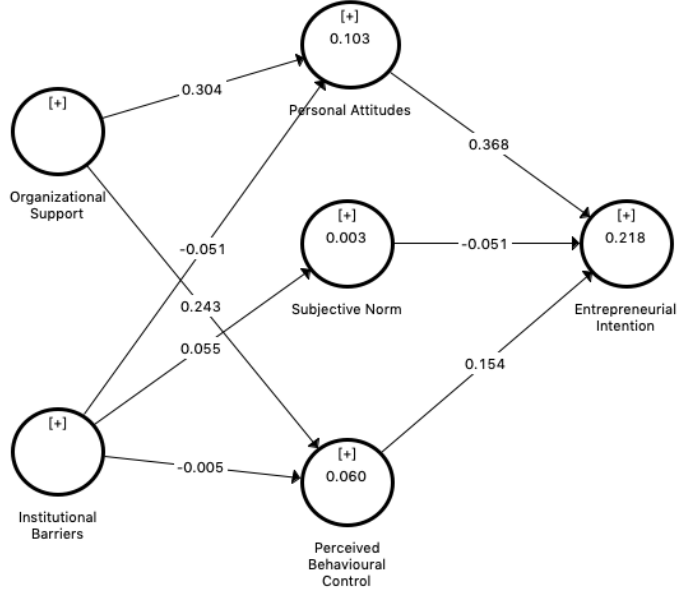
Figure 2. Path model with standardized factor loadings. Table 7. Direct, indirect, and total effects on entrepreneurial intent.